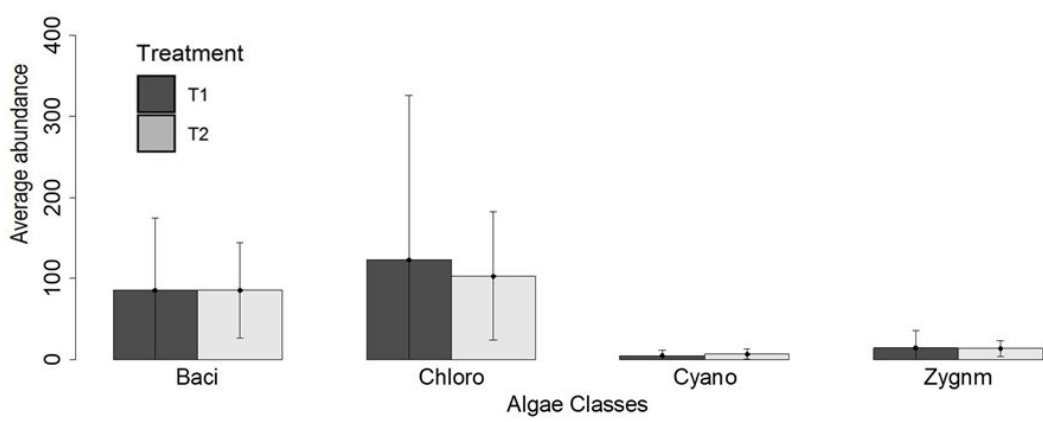
Figure 2. Abundance of the main periphytic algal classes recorded in the treatments (Baci - Bacillariophyceae; Chloro - Chlorophyceae; Cyano - Cyanophyceae; Zygnm - Zygnemaphyceae. T1 (without zooplankton) and T2 (with